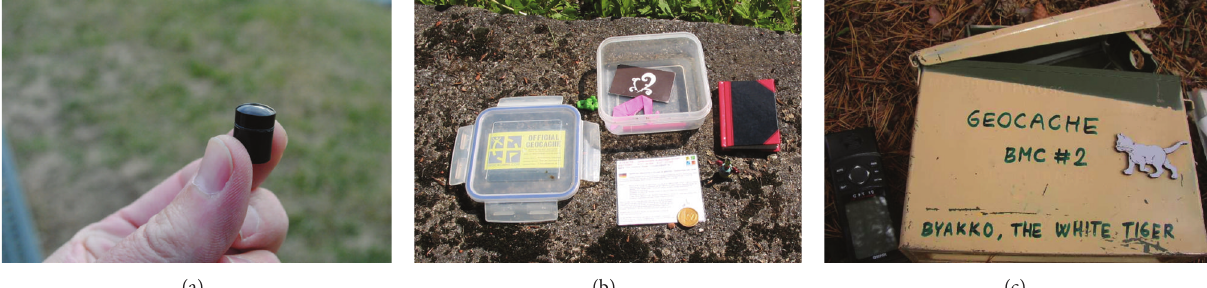
Figure 1: Geocache sizes: A microcache (a) (cc-zero), a small to regular sized cache (b) (by Lee Cannon licensed under the terms of the cc-by-sa-2.0), and a large cache (c)